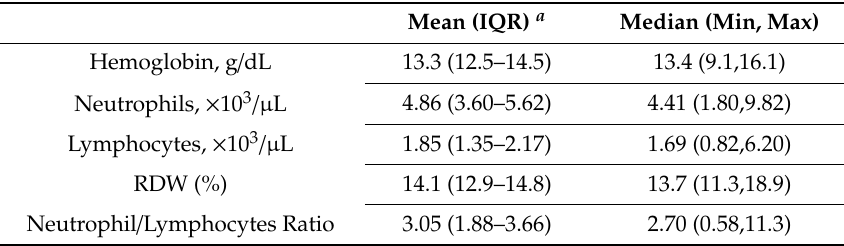
Table 3. Blood parameter summary statistics.